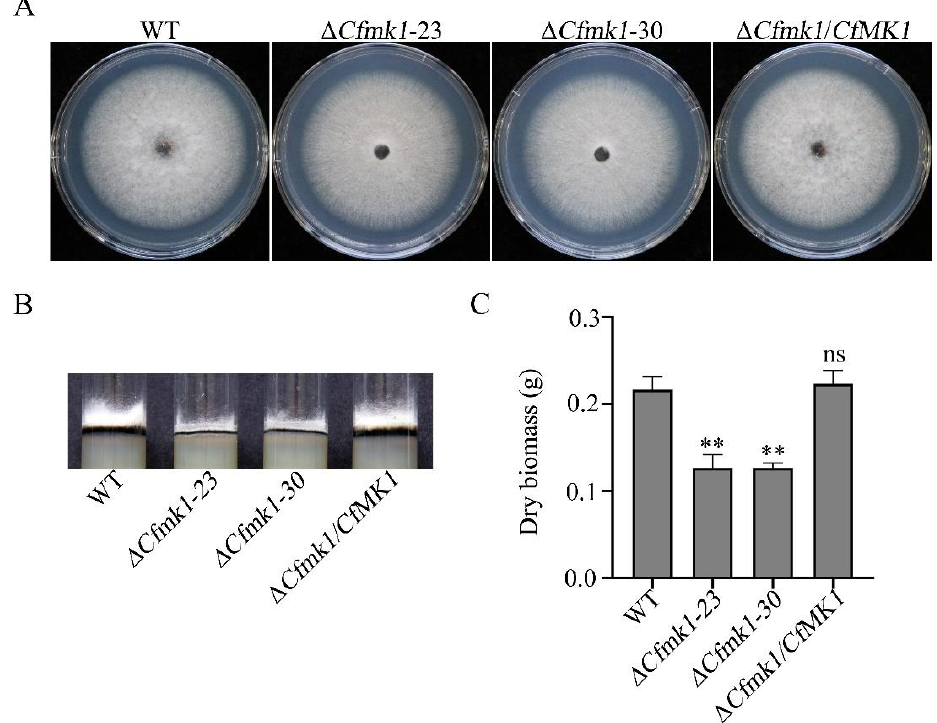
Figure 1. Loss of CfMK1 impairs aerial hyphal growth. ( A ) Five-day-old PDA cultures of the WT, Cfmk1 mutants (Δ Cfmk1-23 and Δ Cfmk1-30 ) and complemented transformant (Δ Cfmk1 / CfMK1 ). ( B ) Aerial hyphal production of the same set of strains was observed when the strains were grown on PDA medium in test tubes. Photographs were taken after 7 days of incubation. ( C ) Dry biomass of the same set of strains after 5 days of growth on PDA plates. The error bars represent the standard deviations based on three independent biological replicates with three technical replicates each. The data were analyzed by a one-way ANOVA followed by Dunnett’s test using GraphPad Prism (version 8.0). The asterisks indicate significant differences ( p < 0.05). ns indicate not statistically significant. Table 1. Defects of the Δ Cfmk1 mutant in growth, conidiation, and plant infection.